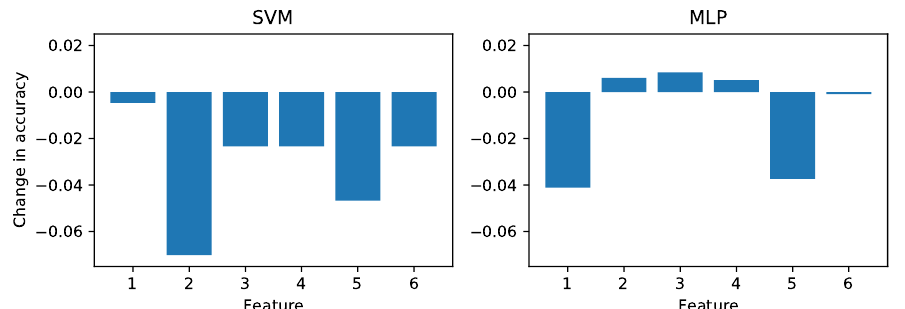
Figure 11. Permutation feature importance for the SVM and MLP models when trained and tested on the laboratory images.